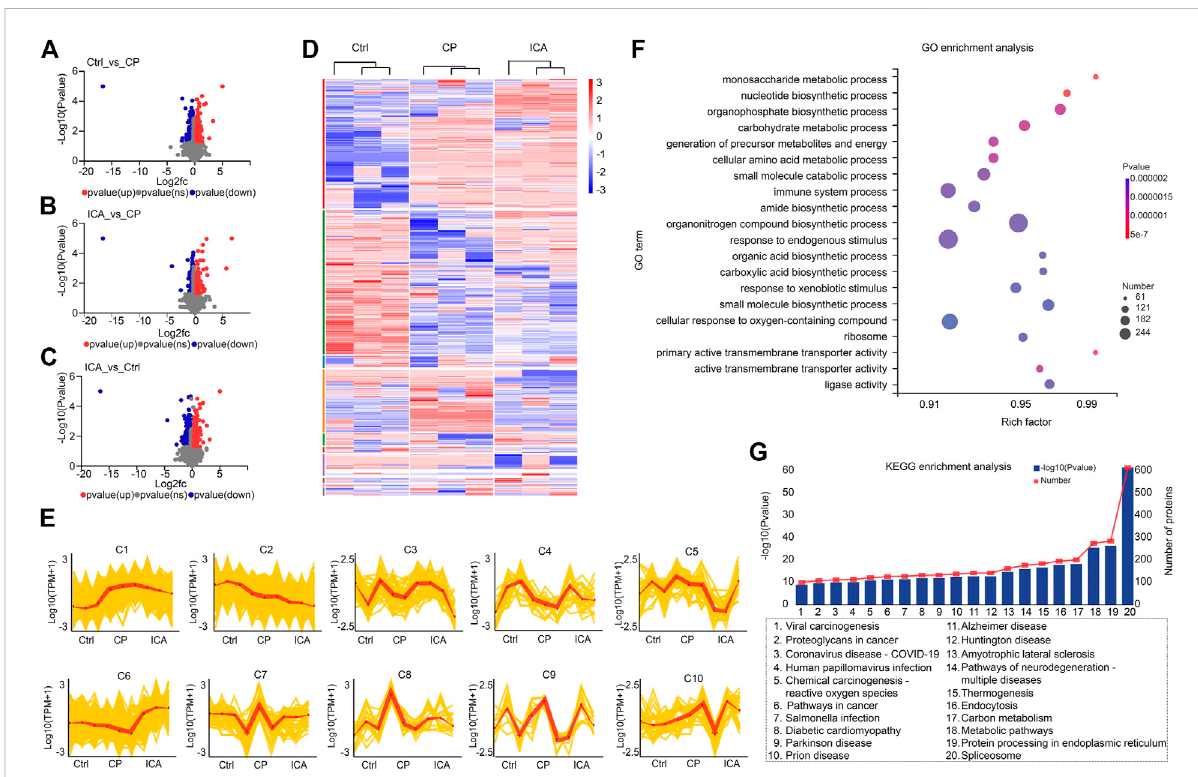
FIGURE 3 Quantitativeproteomicanalysisof testis inCtrl, CP, and ICA mice. (A) Volcano plot ofDEPs in destructive testis inducedby CP comparedto the controltestis. (B) VolcanoplotshowingDEPsintestistreatedwithICAcomparedtothedestructivetestis. (C) VolcanoplotcomparingDEPsbetween ICA-treated testis and control testis. (D) Dysregulated proteins in different groups shown as a heatmap. (E) The expression trends of proteins in ten sub-clusters. (F) The top 20 enriched GO terms of dysregulated proteins. The x -axis indicates the enrichment factor (RichFactor) which representsthenumberofDEPsannotatedforeachpathwaydividedbythenumberofallidenti fi edproteinsannotatedtothesamepathway.Agreater RichFactor indicates greater enrichment. The Y -axis shows the match ratio of GO terms. Bubble size represents the number of differentially expressed proteins in the pathway, and color indicates enrichment signi fi cance. (G) Top 20 dysregulated protein KEGG